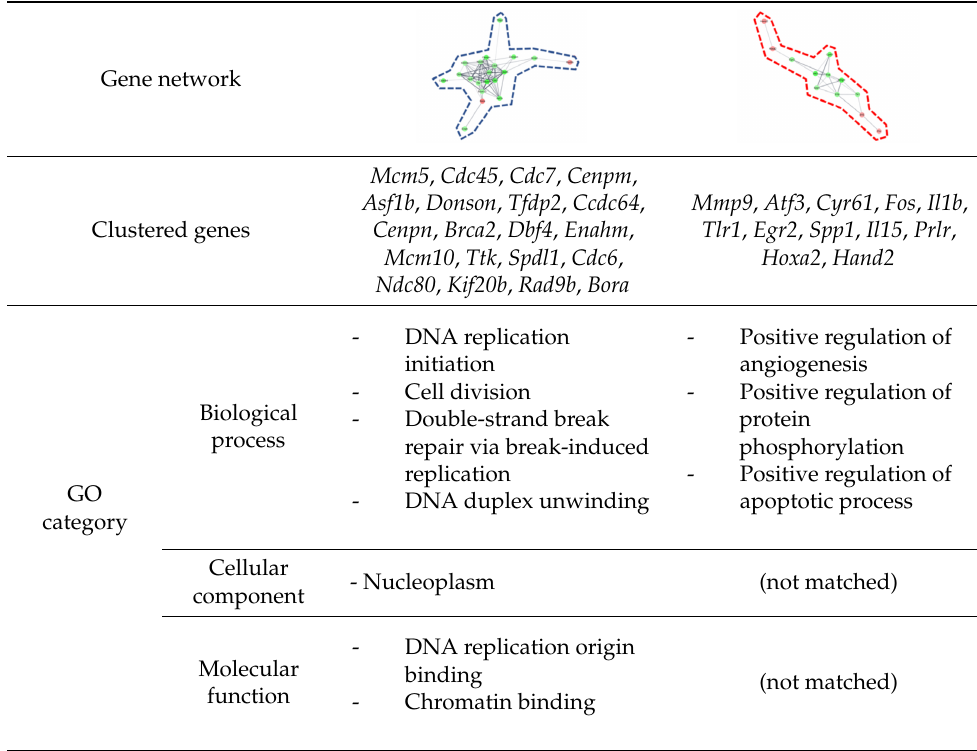
Table 1. Functional annotation of clustered DEGs by DAVID in Figure 2e.